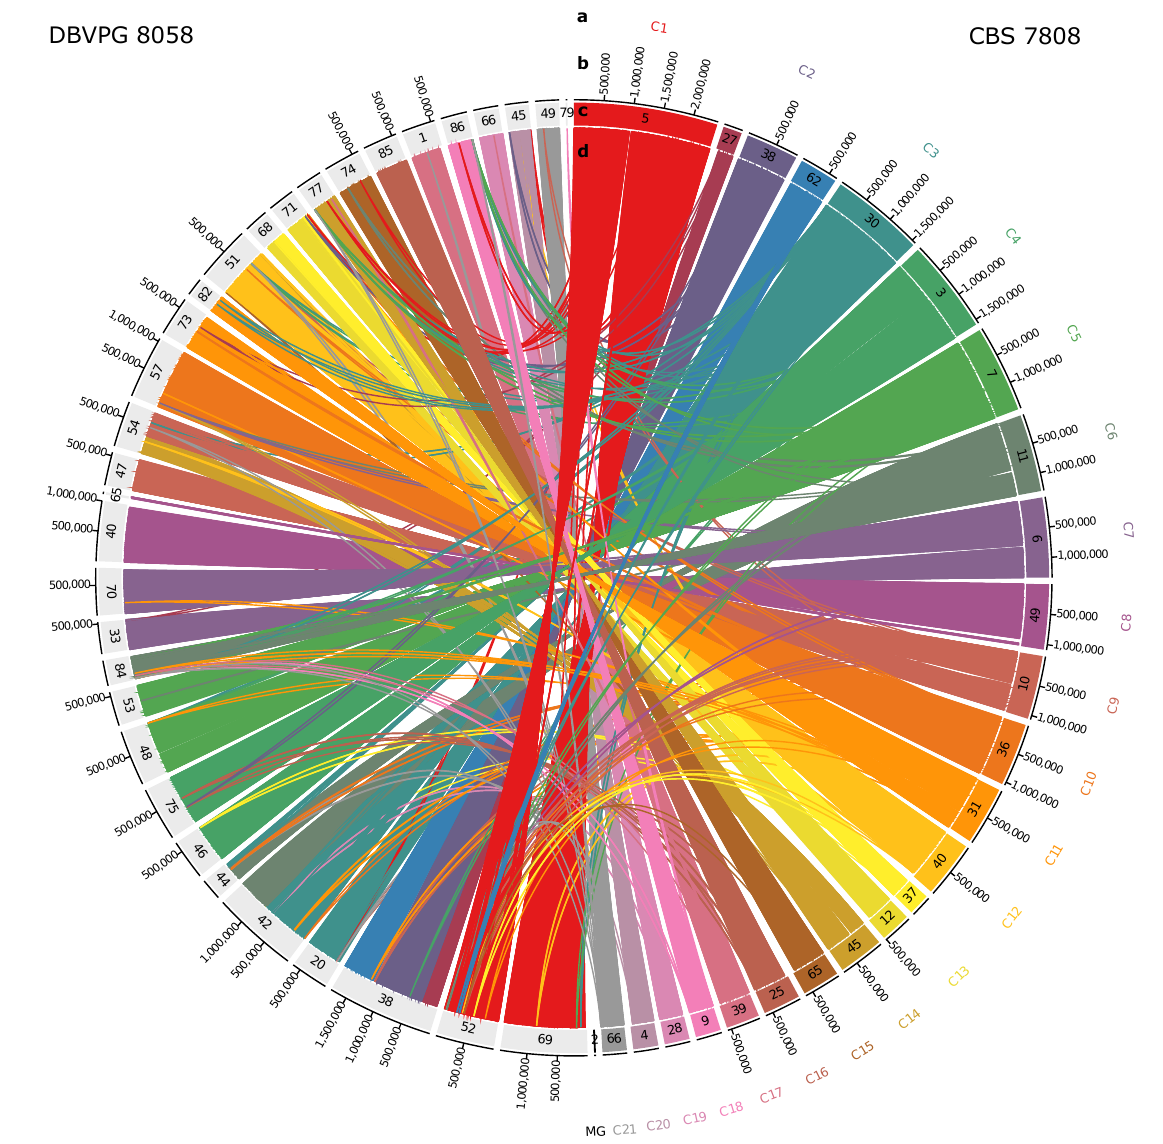
Figure 4. Genome alignment of Rhodotorula babjevae strains CBS 7808 and DBVPG 8058. Maximal unique matches between CBS 7808 and DBVPG 8058 were obtained using NUCmer 3.0 and visualized with Circa. The concentric circles show from outside to inside: putative chromosome names or mitochondrial genome, MG, in the reference strain CBS 7808 ( a ); contig and scaffolds ’ sizes ( b ); and names ( c ). Ribbons are showing the unique and repetitive alignments using CBS 7808 contigs and scaffolds as the reference ( d ). Contigs from DBVPG 8058 are colored gray. Table 2. Putative chromosomes in Rhodotorula babjevae deduced from whole genome LASTZ align- ments (Table S7, Figure S8 ) . R. bajevae CBS